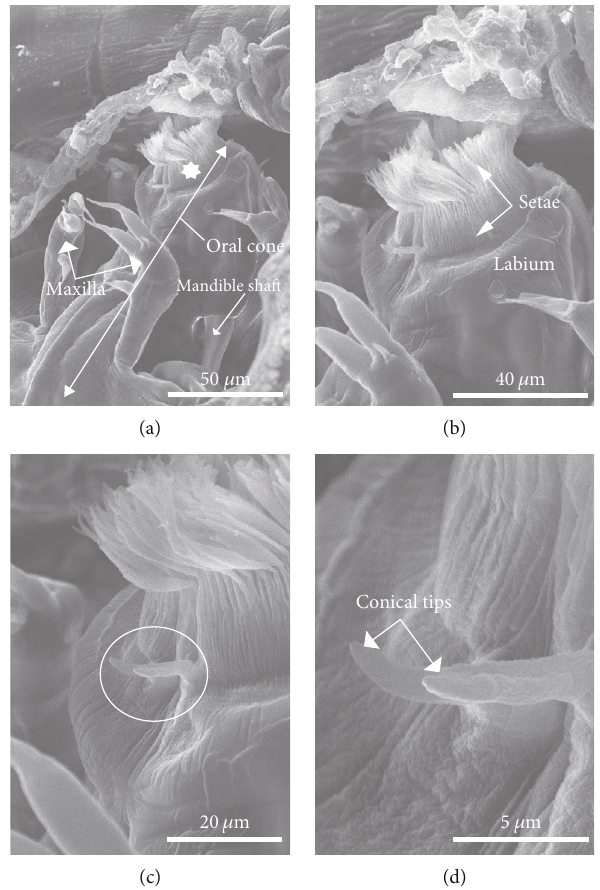
Figure 6: Detail of the feeding apparatus. (a) Oral cone (large double-headed arrow) with maxilla (arrows) and seta crowning the oral tube (star). Note the mandible shaft (arrow). (b) Detail of the oral crown and border of blade-like setae (arrows). Note adjacent supporting labium. (c) High-resolution image showing the oral crown with rigid conical setae (circle). (d) Further high-resolution detail of rigid setae demonstrating the conical nature of the tips